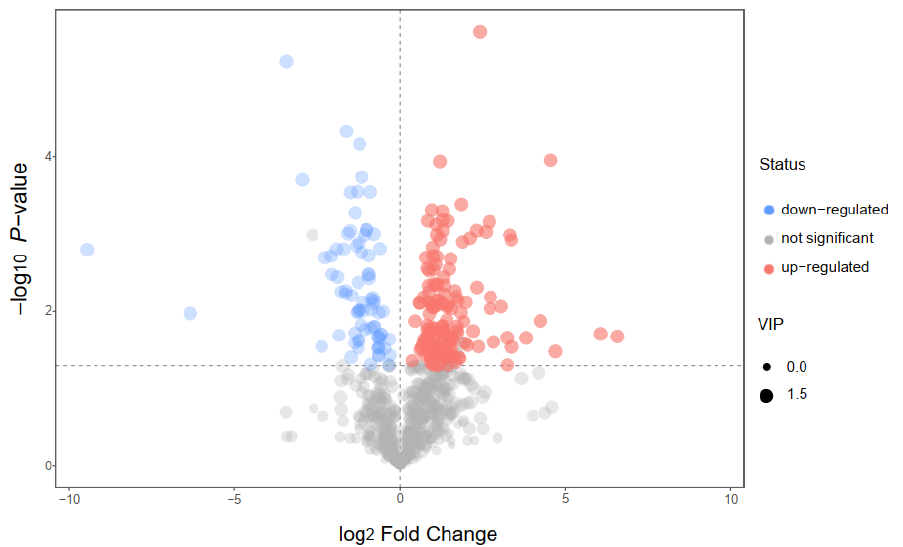
Figure 2. Volcano plot for group IC-P vs. IC-E.